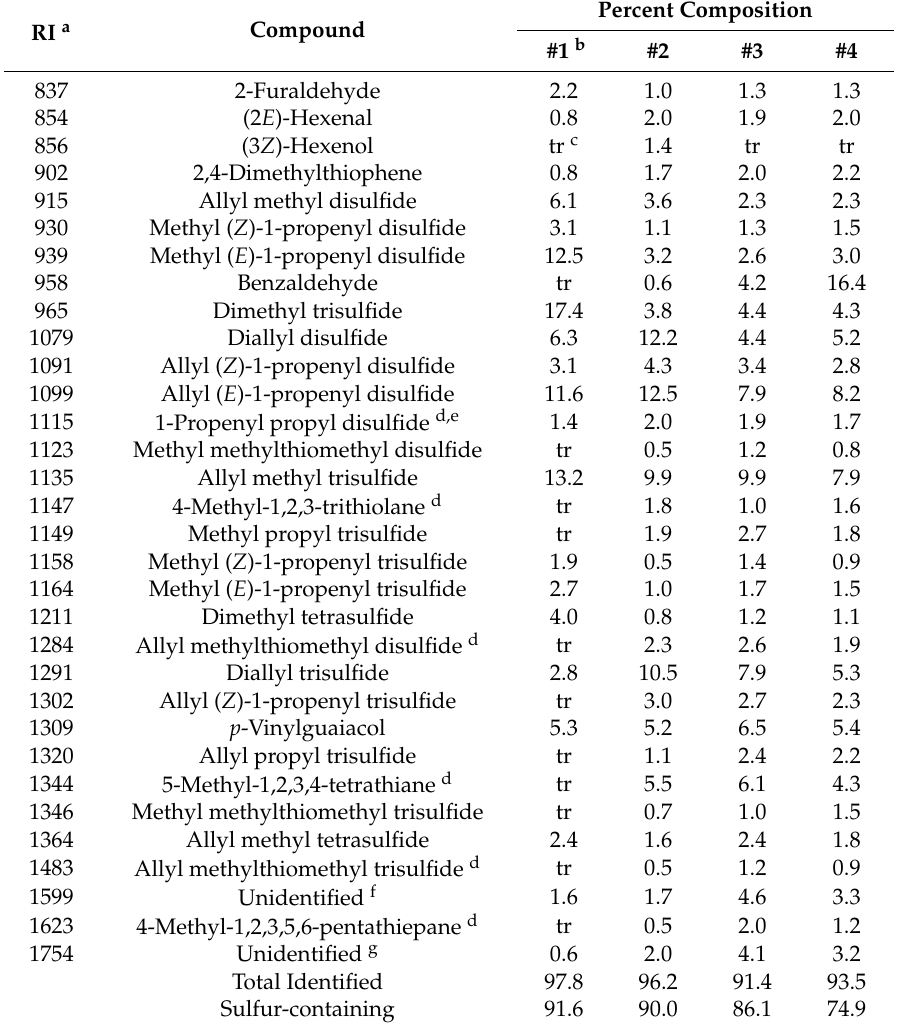
Table 3. Essential oil compositions of wild garlic ( Allium vineale ) growing wild in north